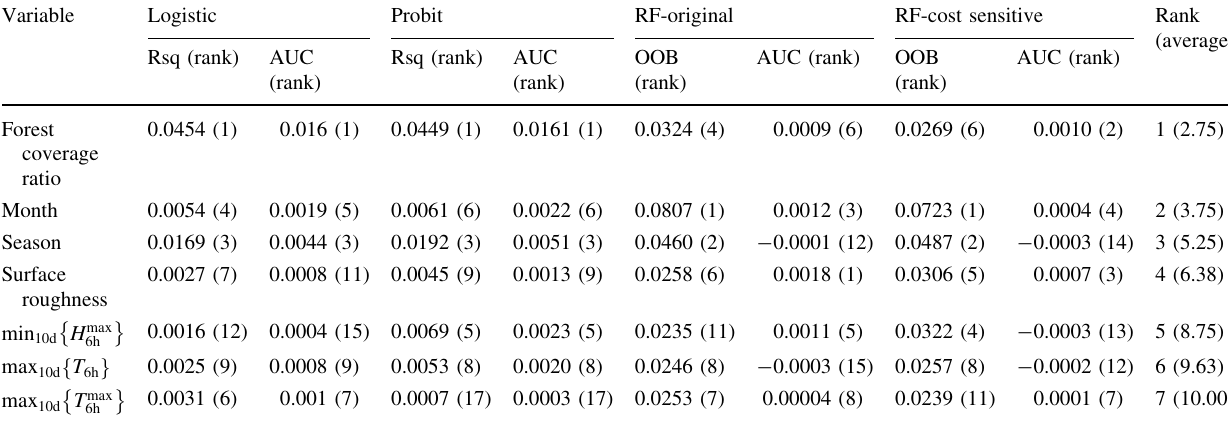
Table 3 List of the seven most important variables in the four models under different measurement methods